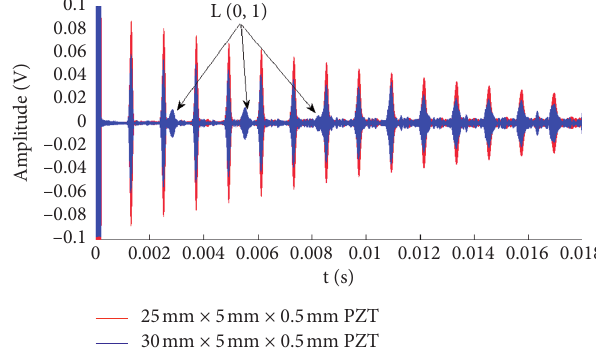
Figure 18: Multiple reflection from the right end of a normal hexagonal pipe at the center excitation frequency of